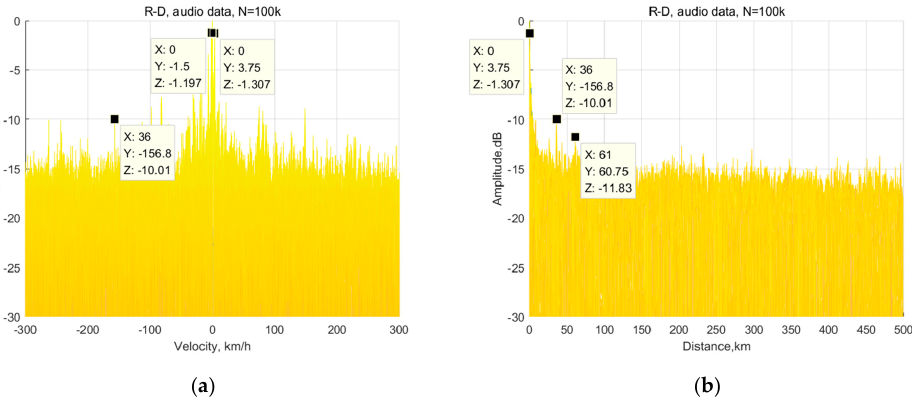
Figure 16. Integration results with traditional R-D processing for the audio signal: N = 10 5 ; ( a ) Doppler dimension; ( b ) Range dimension.